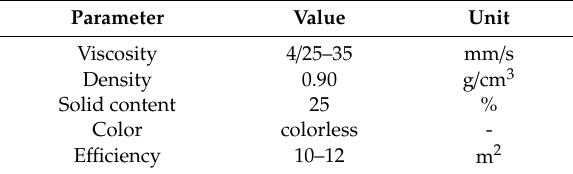
Table 3. Characteristics of semi-matte nitrocellulose multicoat lacquer Solak NC 352520.